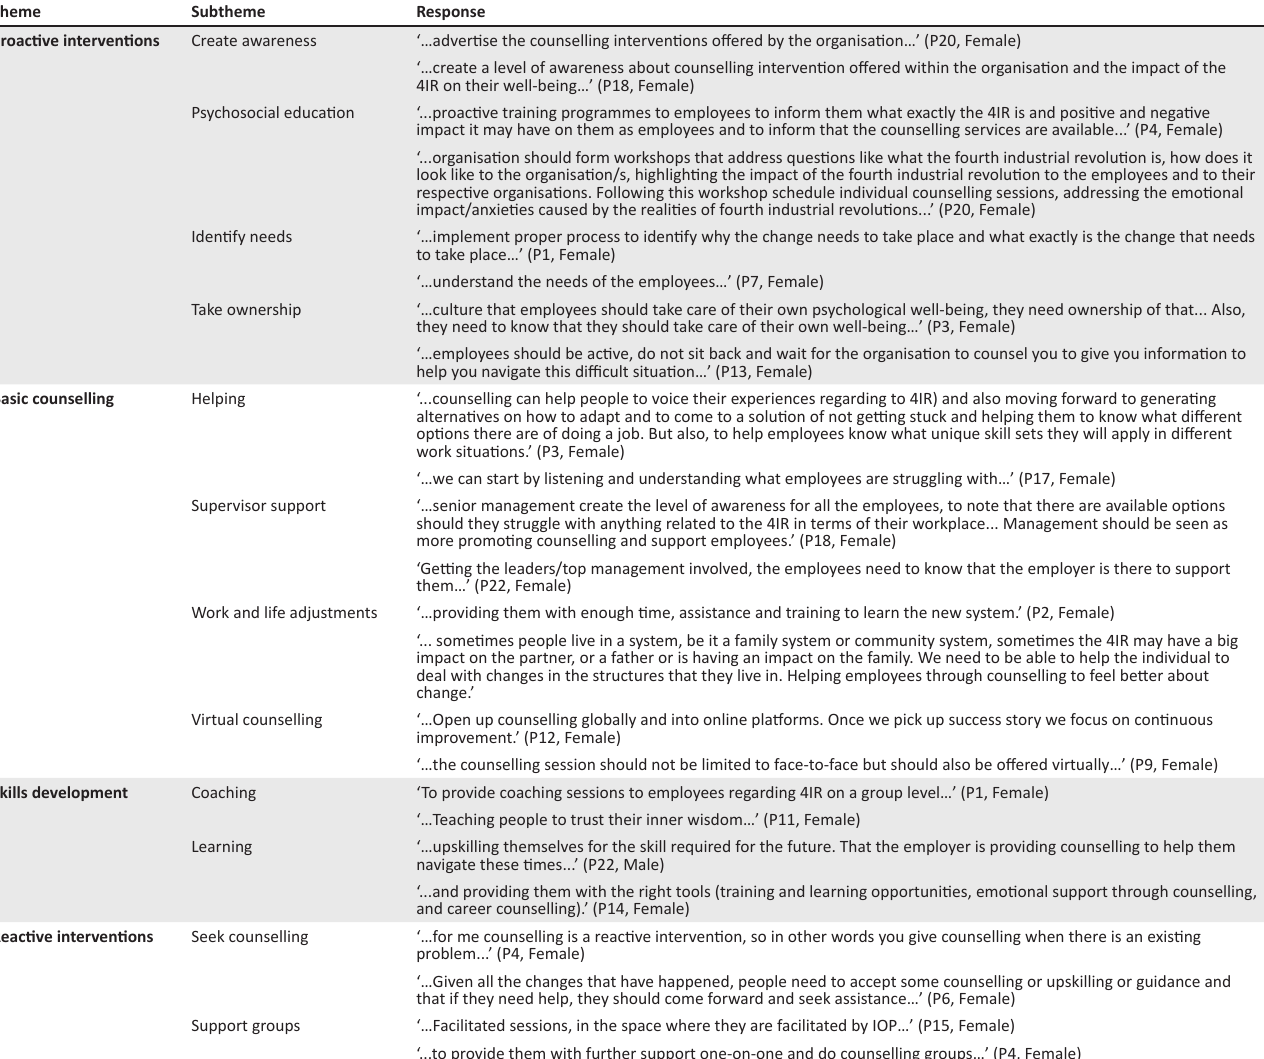
TABLE 3: Category 3: Recommendations to assist employees in the new world of